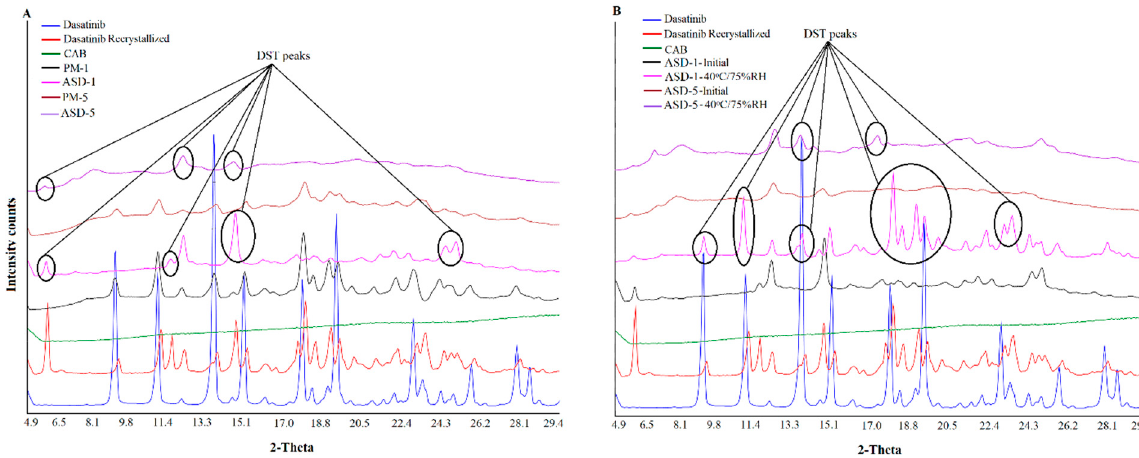
Figure 2. X-ray powder diffractogram of ( A ) PM − 1, PM − 5 ( B ) ASD − 1, ASD − 5 initial and 40 °C/75% RH